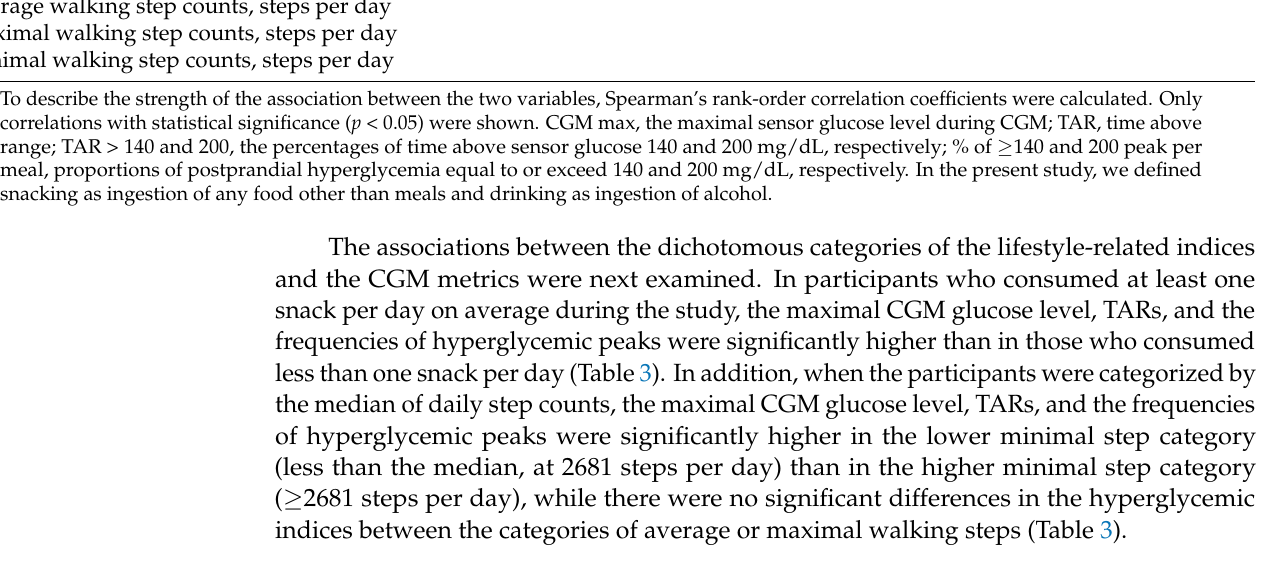
Table 3. Median (IQR) of CGM metrics according to the lifestyle-related factor